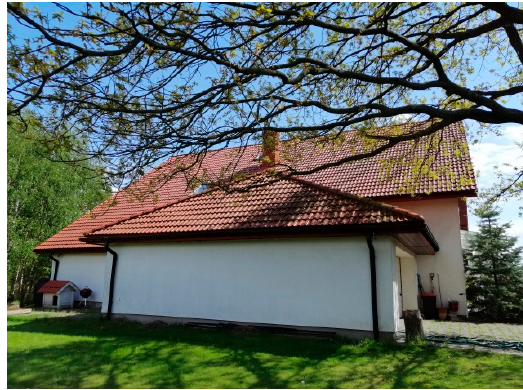
ff er space of the